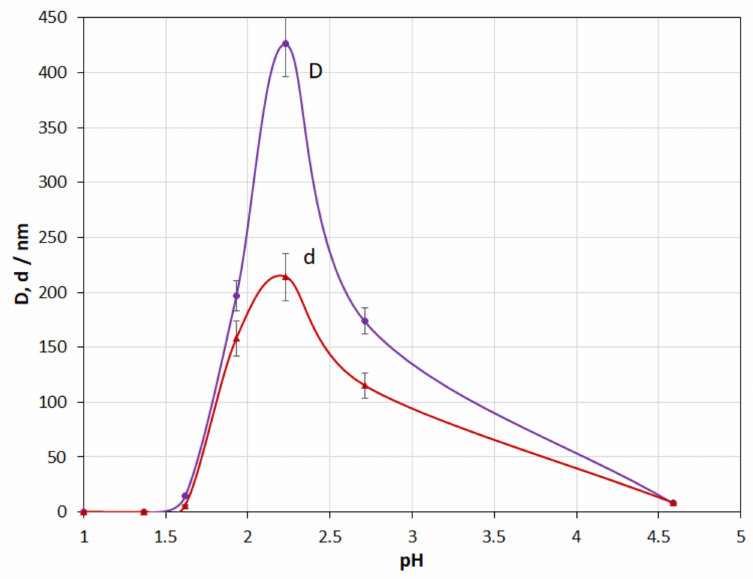
Figure 6. Dependence of the average coating thickness (D) and average particle size (d) on the pH of the reaction medium.